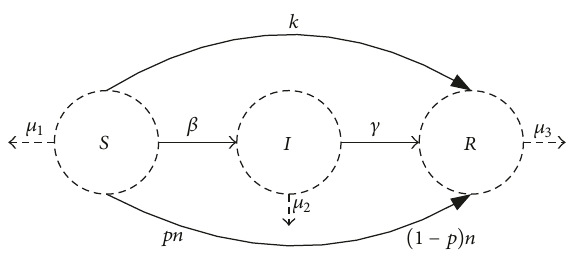
Figure 5: Virus propagation model.